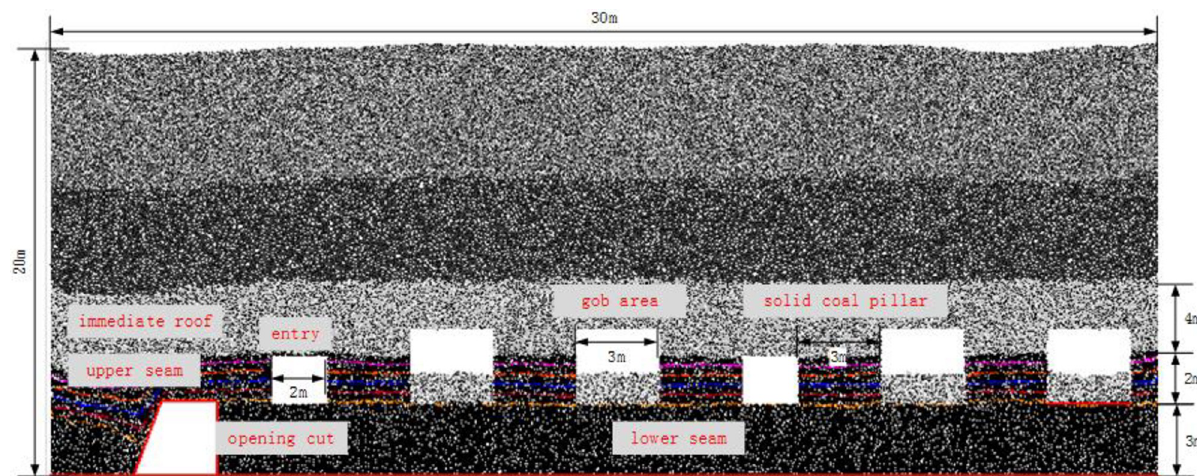
Fig 2. Numerical model showing the layout of re-mined lower seam and the previously partially mined-out upper seam.